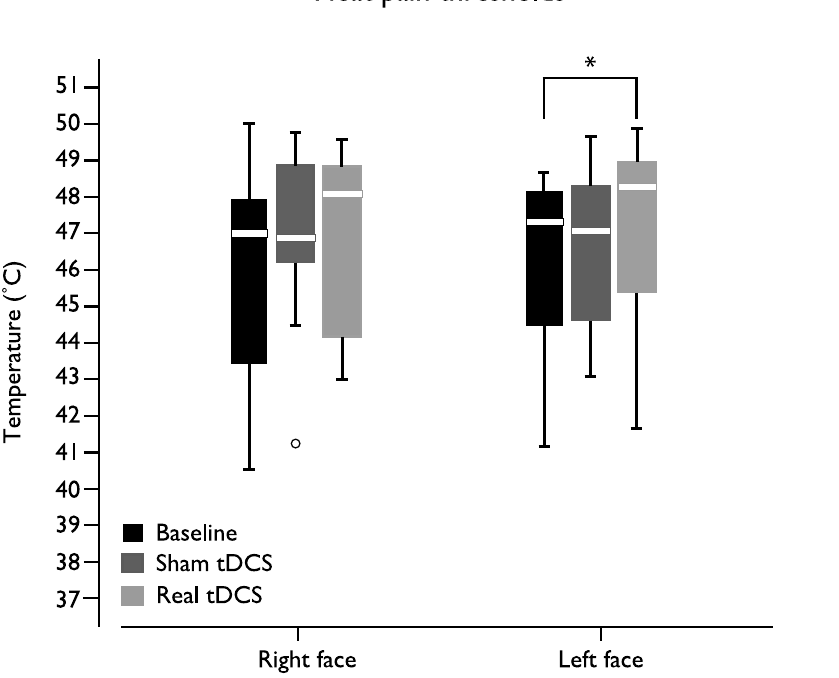
Figure 4. Box plot representing tDCS (placebo and real) effects in the heat pain thresholds of both sides of the face. Statistically significant changes occurred in the heat pain thresholds of the left face ( p =0.032).